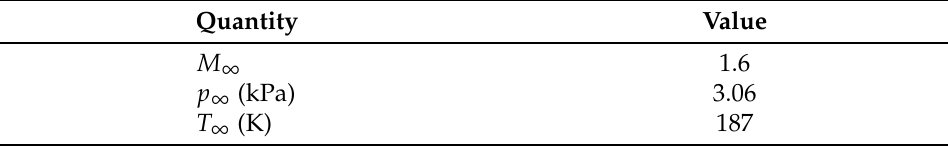
Table 8. Flow Conditions.